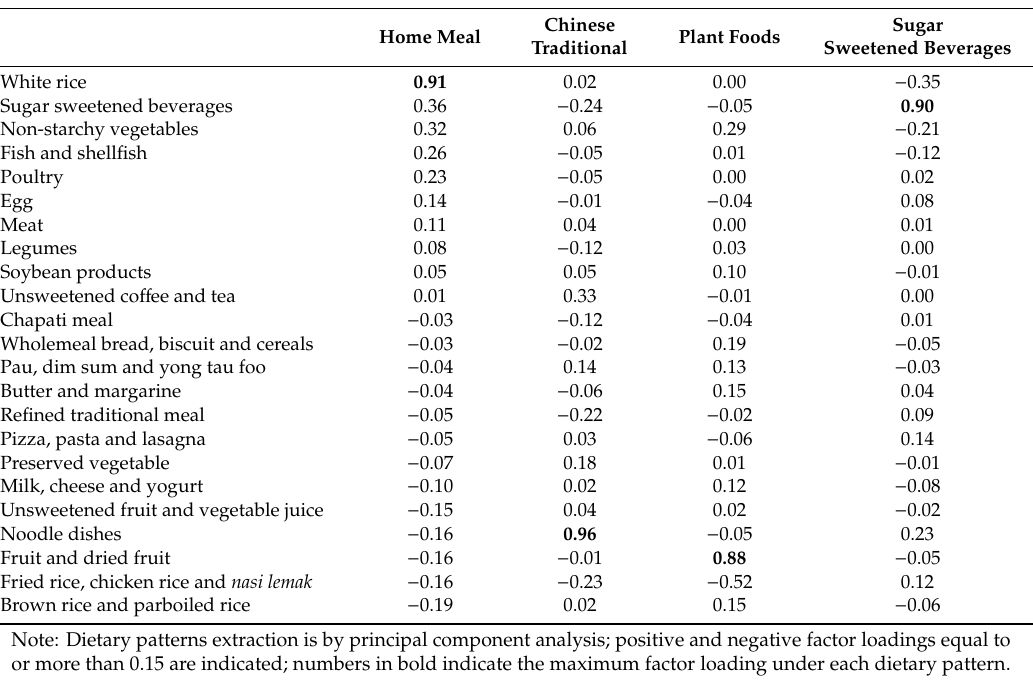
Table 2. Factor loadings for four dietary patterns in the MLS population ( n = 562).